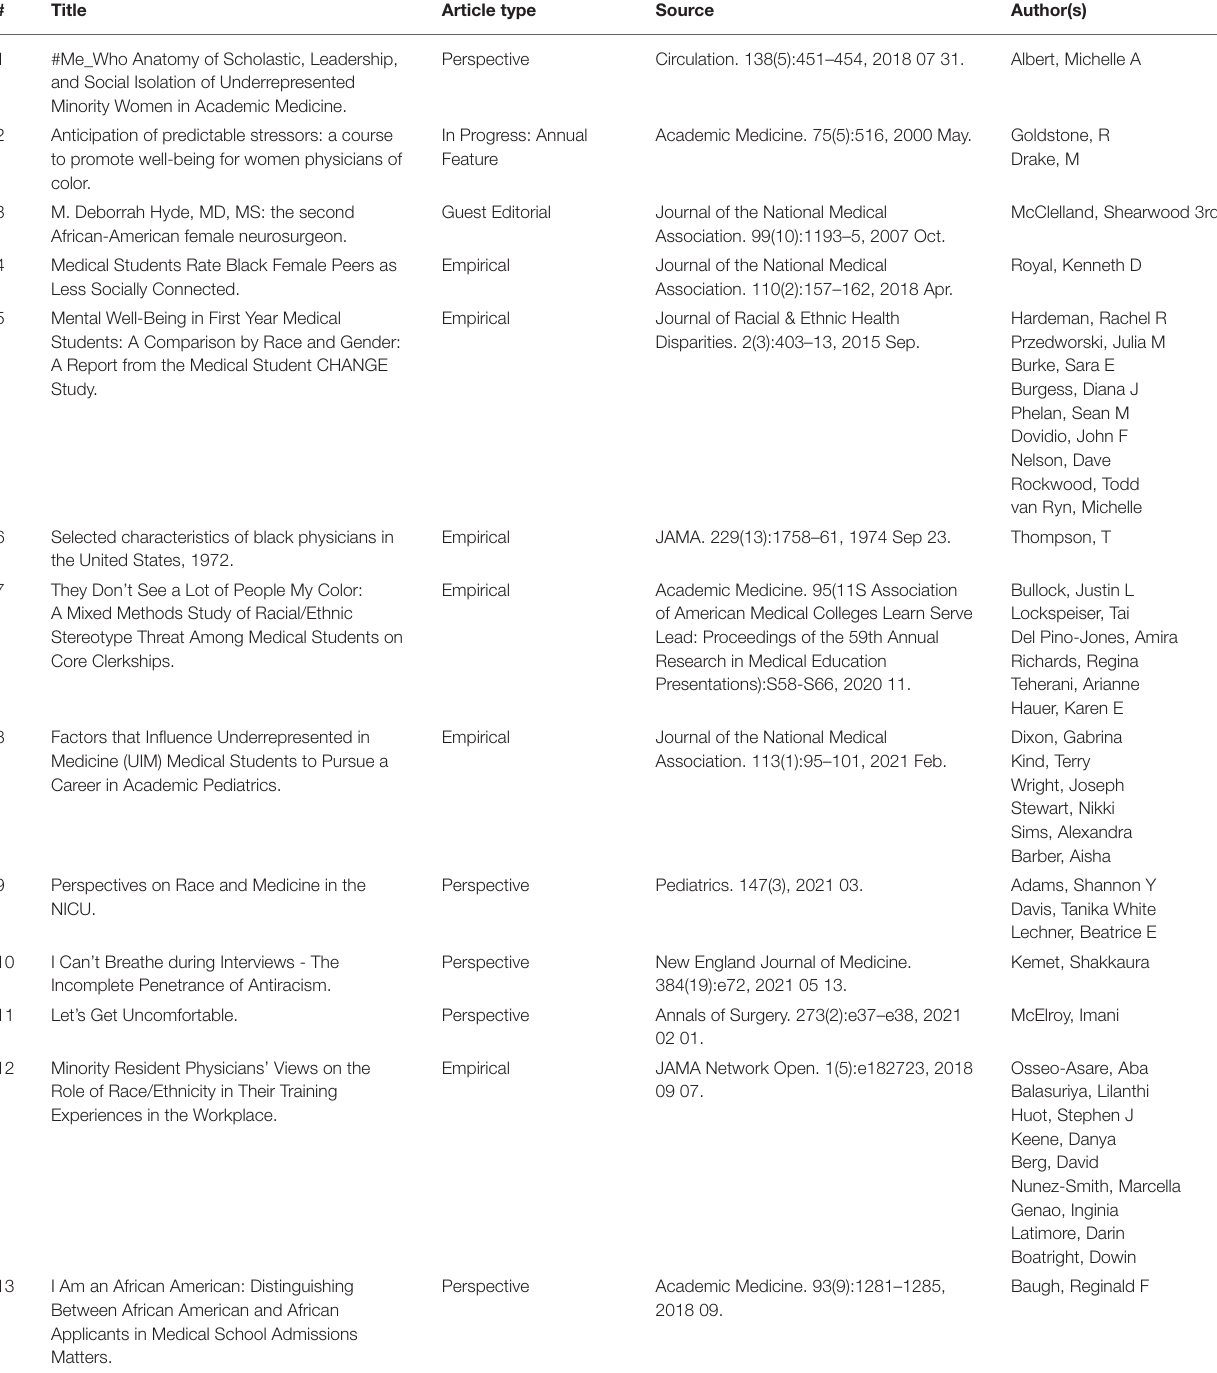
TABLE 1 | Studies explicitly mentioning Black women medical students and